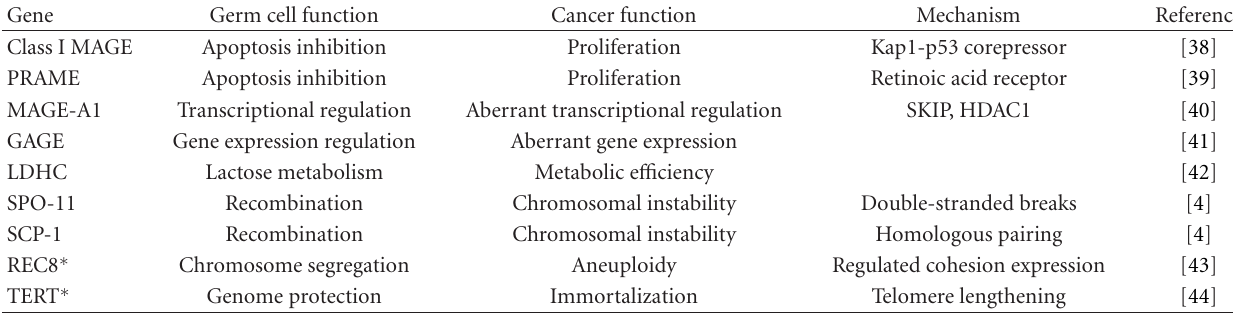
Table 3: Germ cell proteins expressed in cancer and proposed